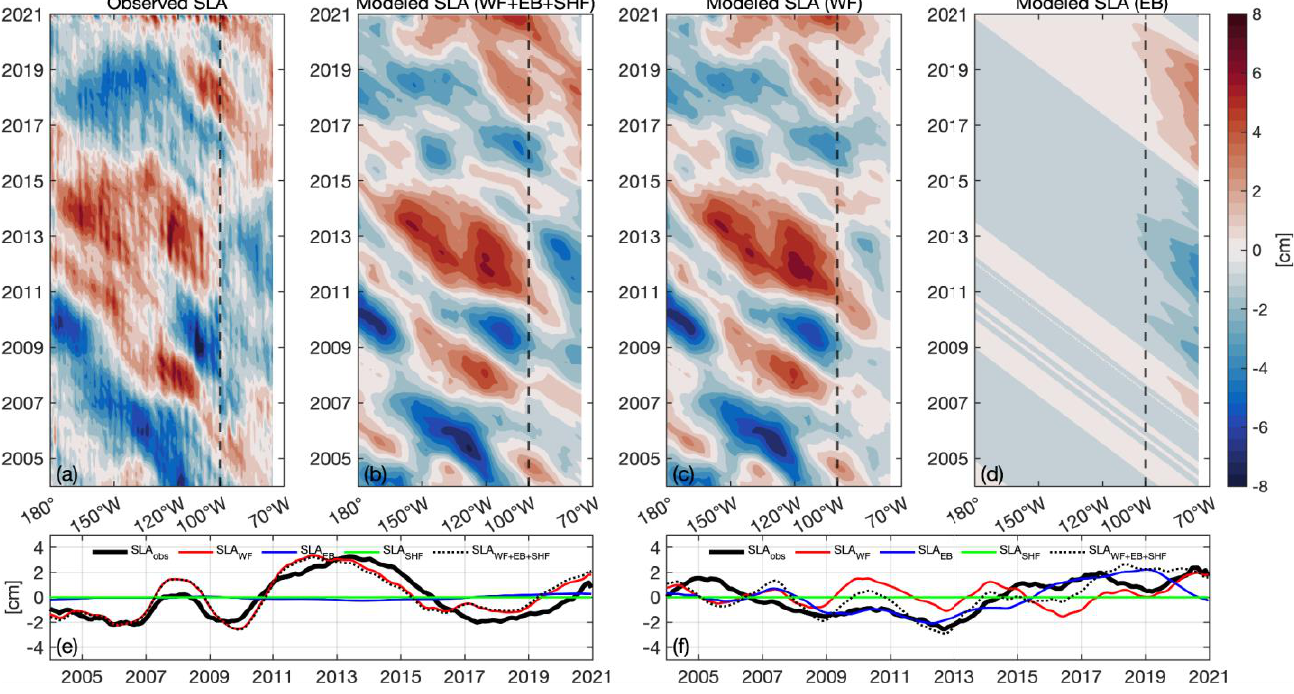
Figure 9. ( a – d ) Time-Longitude diagrams of mid-South Pacific (averaged over 34°S – 36°S) interannual sea level anomaly (SLA) signals from 180° (east of New Zealand) to 75°W (at the eastern boundary, close to the Chilean coast) during 2004 – 2020. ( a ) Observed SLA from satellite altimetry (the 1993 – 2020 global mean sea level is removed). ( b ) Modeled SLA due to wind-forced baroclinic Rossby waves, time-varying SLA signals at the eastern boundary and diabatic surface heating. ( c ) Modeled SLA patterns forced only by wind-stress curl anomalies (WF), ignoring SLA signals propagating from the eastern boundary. ( d ) Modeled SLA considering the eastern boundary forcing (EB) only. ( e , f ) Time series of (i) the observed SLA (solid black curves), (ii) modeled SLA with wind forcing only (red curves), (iii) modeled SLA with the eastern boundary forcing only (blue curves), (iv) modeled SLA with the net surface heat flux forcing (derived from ERA5 atmospheric reanalysis) only (green curves), and (v) modeled SLA combining all forcing (dotted black curves) averaged over 100°W – 180° in ( e ) and 75°W – 100°W in ( f ).